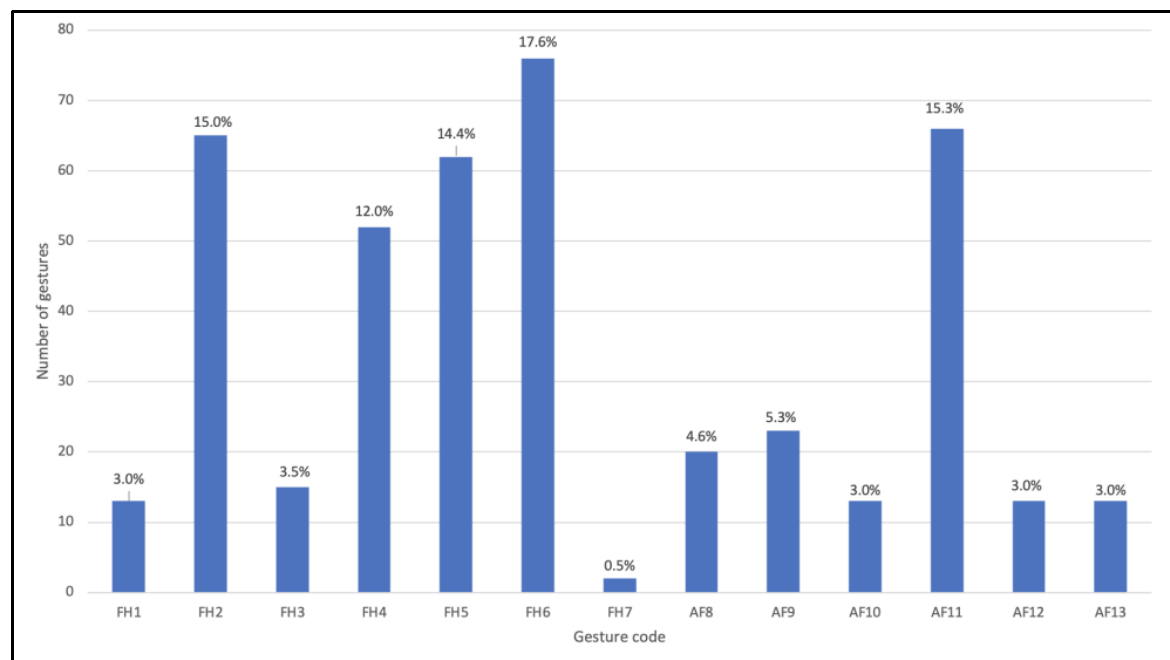
Figure 8. Gesture taxonomy breakdown using CrossG.